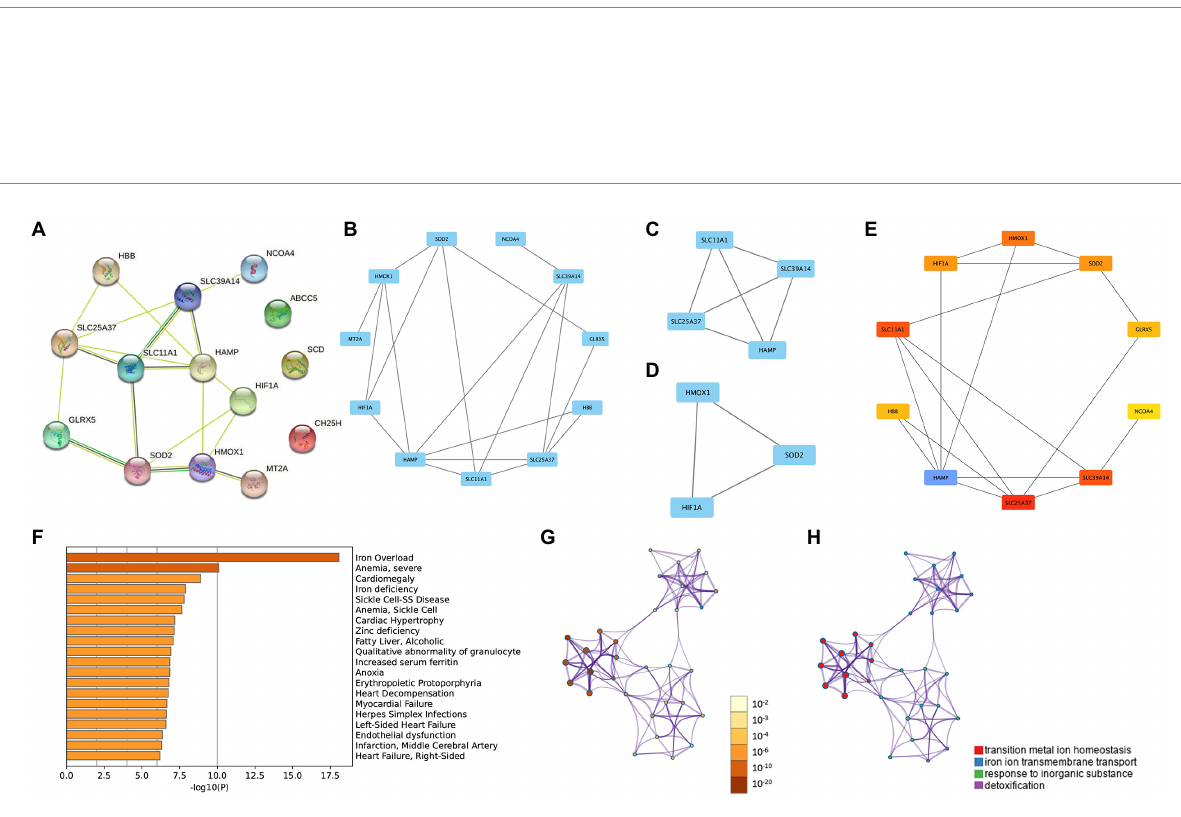
FIGURE 3 Protein–protein interaction (PPI) networks in common DEGs of iron metabolism. (A) PPI network formed by common differentially expressed IMRGs. (B–D) The top three MCODE complexes. (E) The top 10 hub genes identified by Cytohubba. (F–H) Enrichment analysis performed by